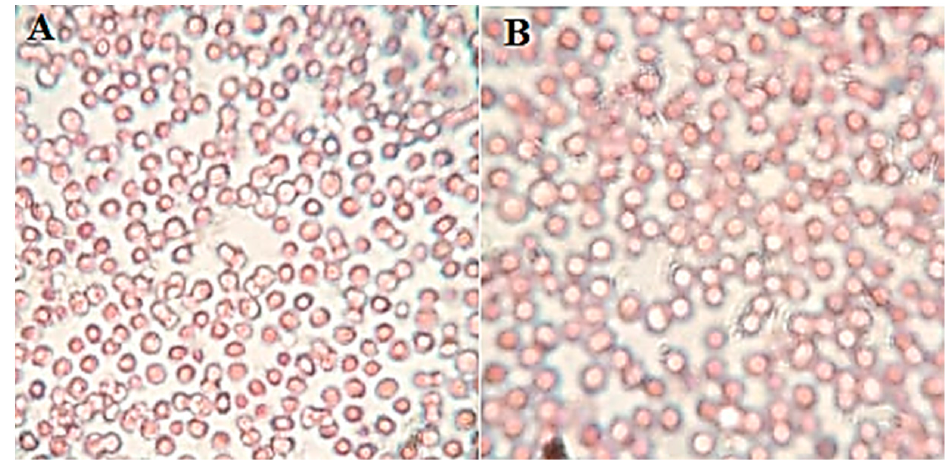
Figure 9. Isotonicity evaluation image of ( A ) AM-NLopIG and 0.9% ( B )